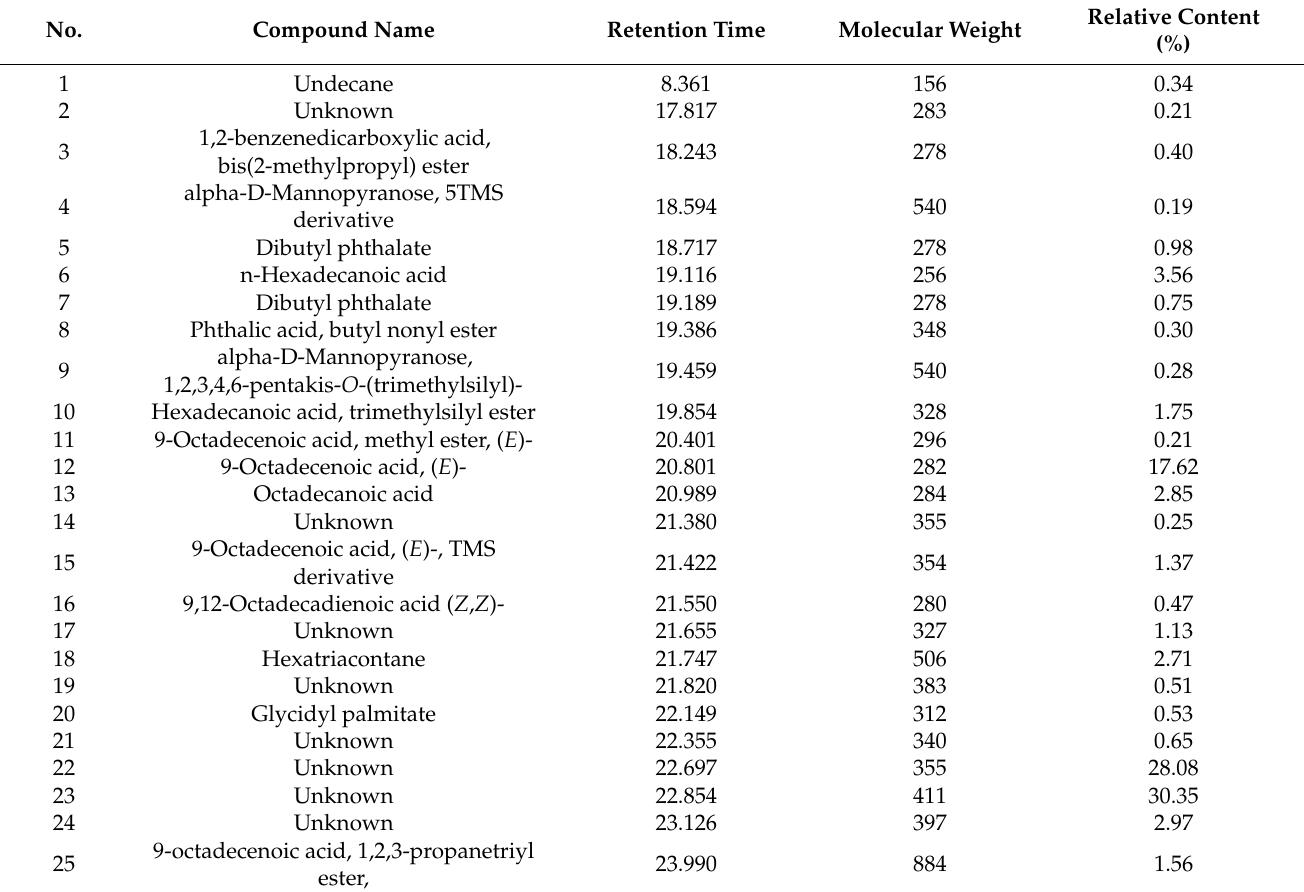
Table 2. Compounds identified from hexane extract by GC–MS